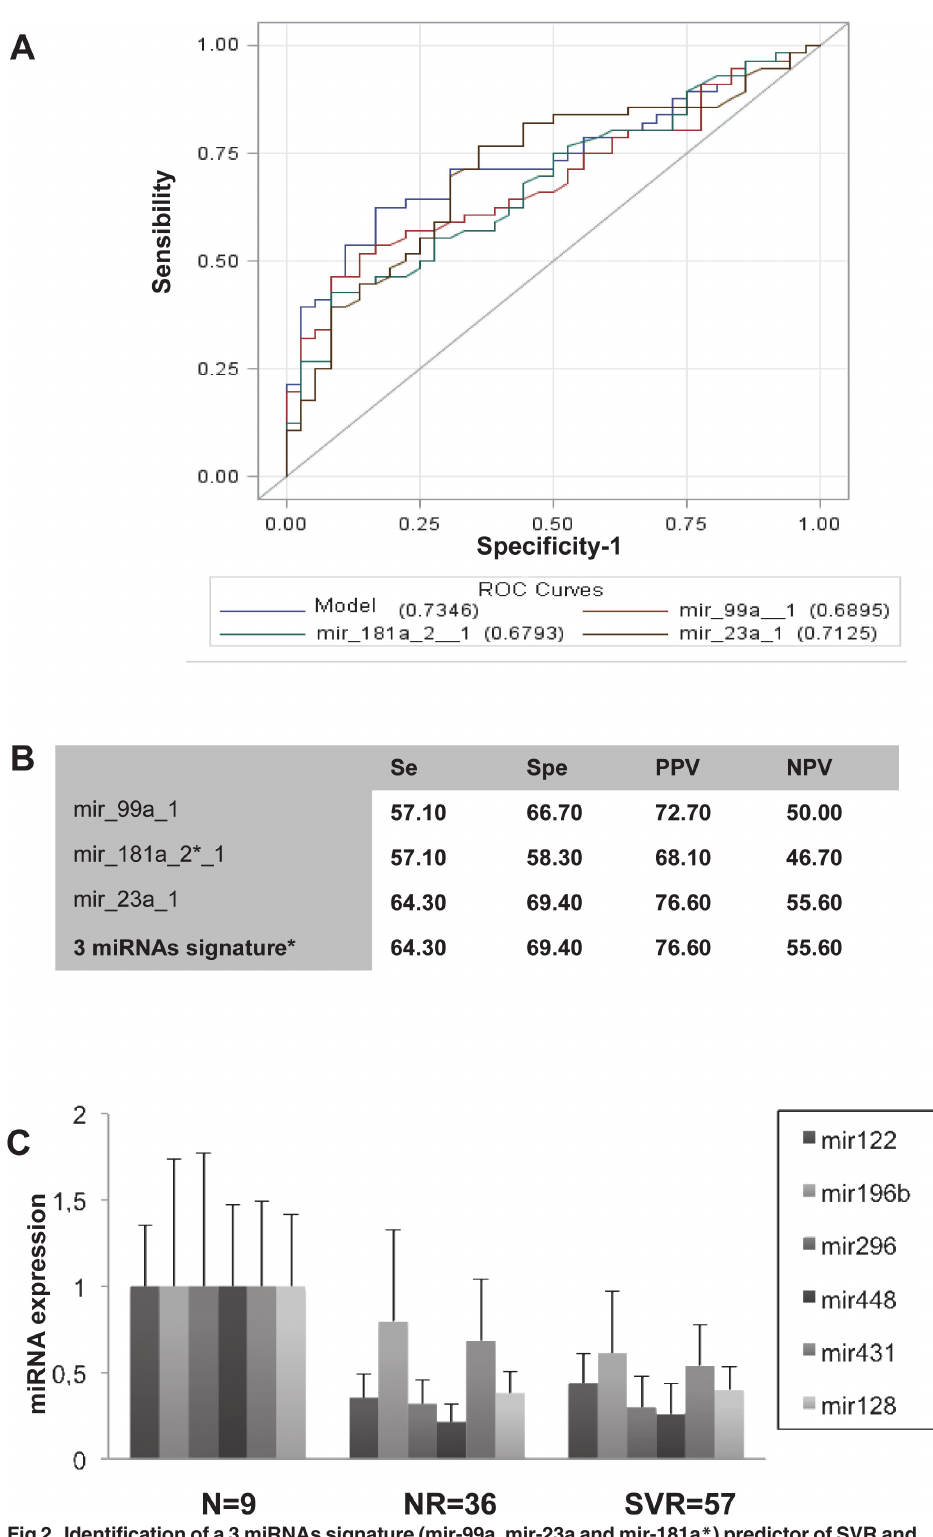
PLOS ONE | DOI:10.1371/journal.pone.0121395 April 6,